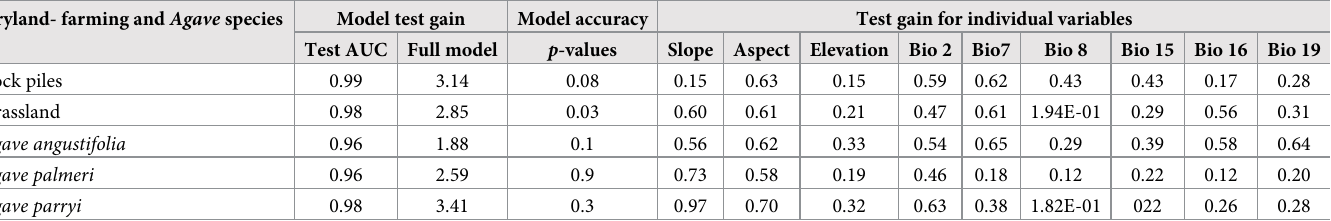
Table 5. Summary of niche models of individual species for dryland-farming and Agave species with test gains of all the variables used to build the distribution models with only one variable. Dryland- farming and Agave